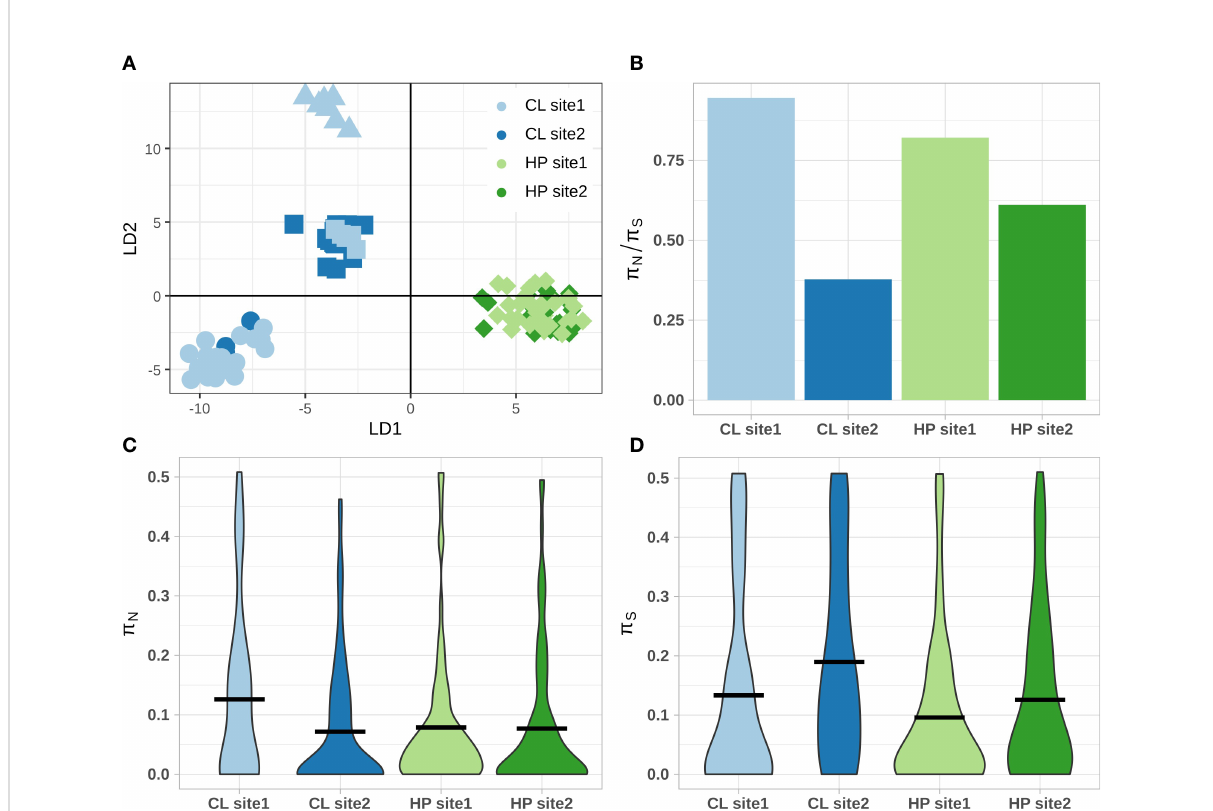
FIGURE 6 Putative trends of selection, polymorphism ratio and non- and synonymous gene diversities for all individuals per sampling population. (A) DAPC cluster analysis for putative environment-linked loci (174 SNPs) for all sampled populations, only the fi rst 2 discriminant functions are shown, shape of data points refers to the genetic cluster (K = 4). (B) average polymorphism ratio p N / p S . (C) Nonsynonymous ( p N ) and (D) synonymous ( p S ) gene diversities, the black horizontal line indicates average population gene diversity ( p ). Colours indicate sampling populations in all panels. CL and HP stand for clonal and haplodiplontic